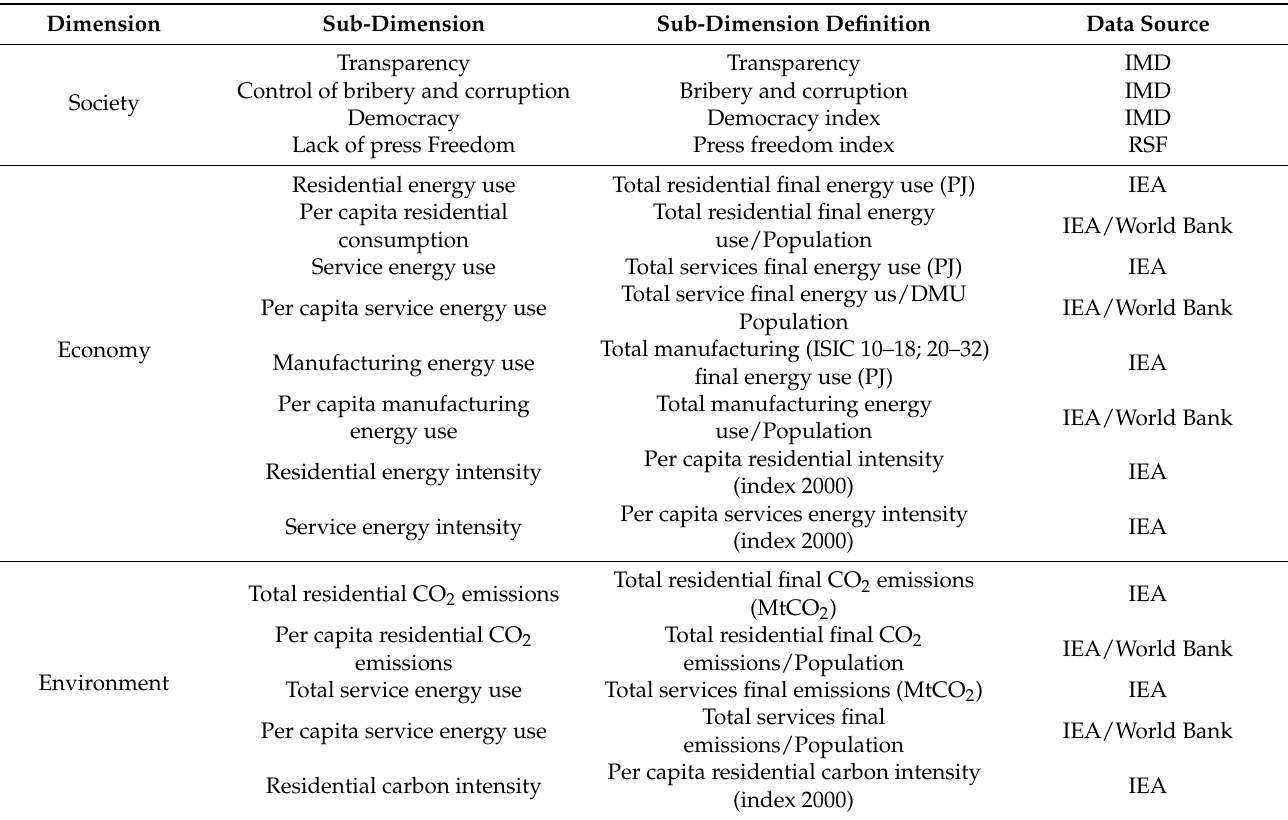
Table 1. Definition and data sources of dimension and sub-dimension.